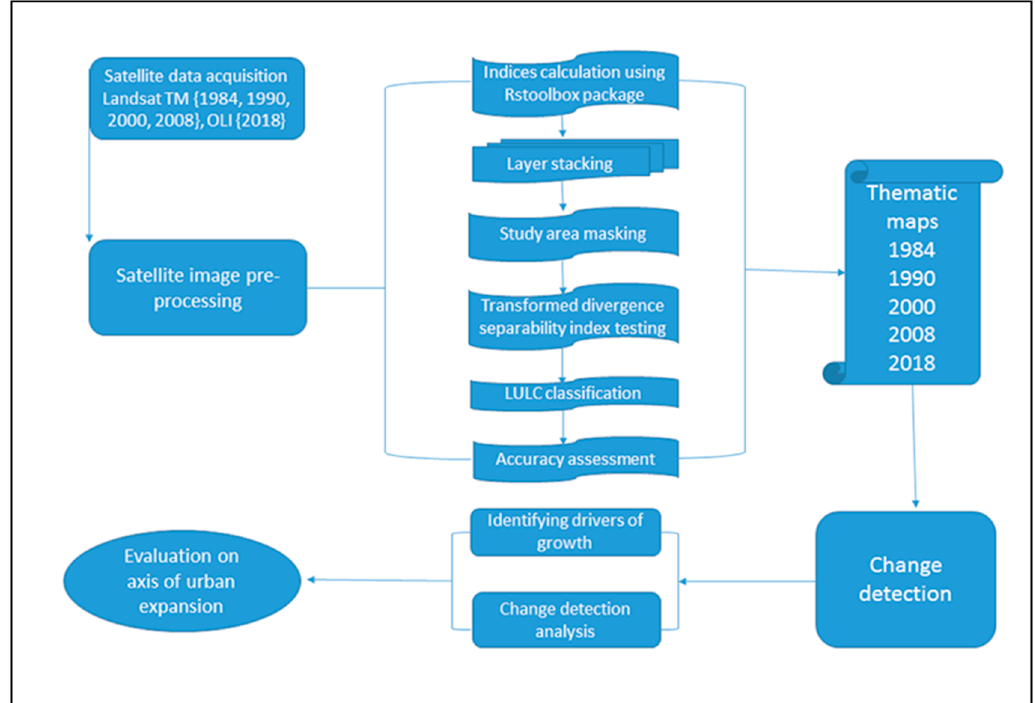
Figure 2. Flowchart showing the determination of drivers and the axis of urban expansion for Harare Metropolitan Province.